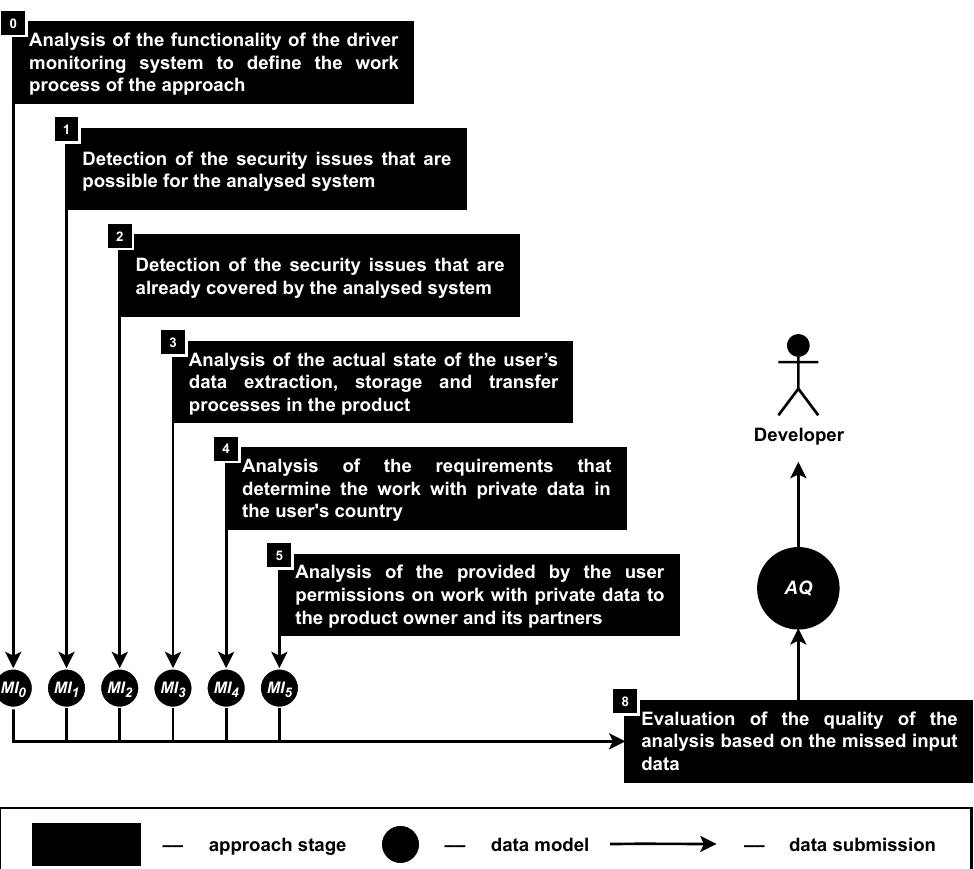
Figure 11. Stage 8—Evaluation of the analysis